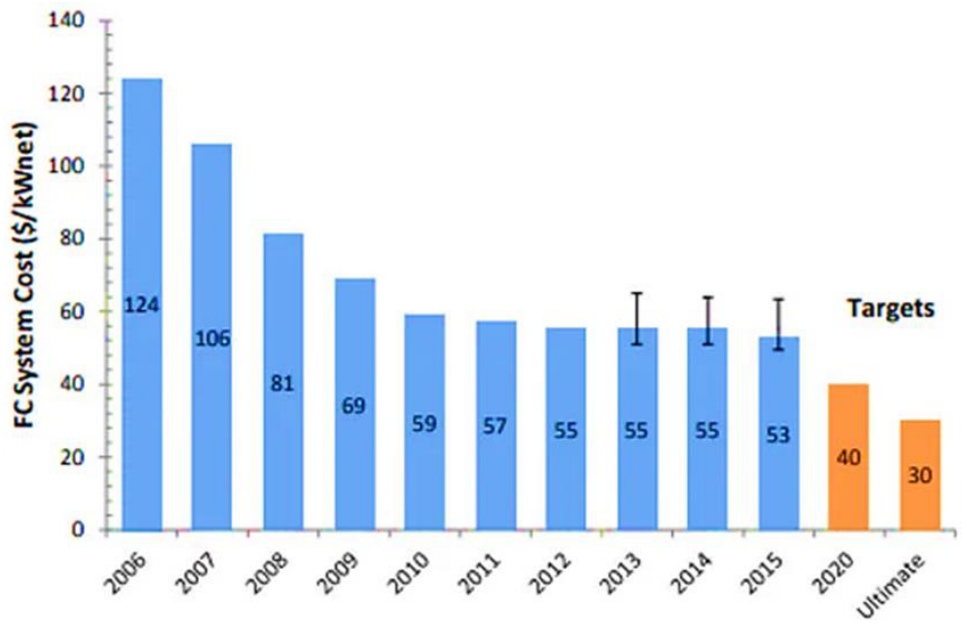
Figure 3. PEMFC system cost at 500,000 units per year [34] (open access).